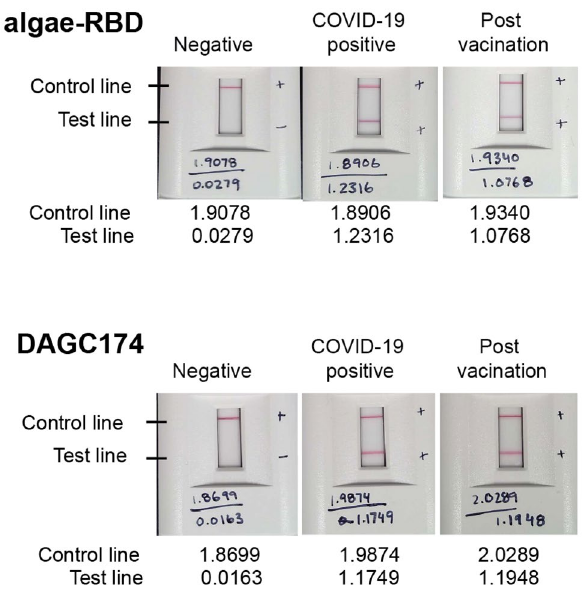
Figure 5. Algae-RBD is serologically active in an LFA device. Representative images of LFA devices with the algae-RBD (top) or DAGC174 RBD (bottom) as the capture antigen. Each test strip has two reaction lines, the control line that detects IgG antibodies, and the test line that specifically captures anti-RBD IgG antibodies. Values reported on each device are optical density readings of the control or test strip. Negative, serum confirmed SARS-CoV-2 negative by PCR; COVID-19 positive, serum confirmed SARS-CoV-2 positive by PCR; Post vaccination, serum post-vaccination with two doses of Pfizer-BioNTech vaccine. Additional data is presented in Supplementary Table